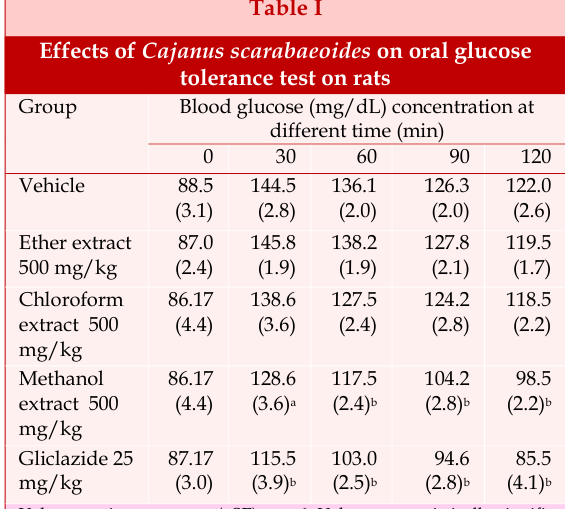
Methanol extract 500